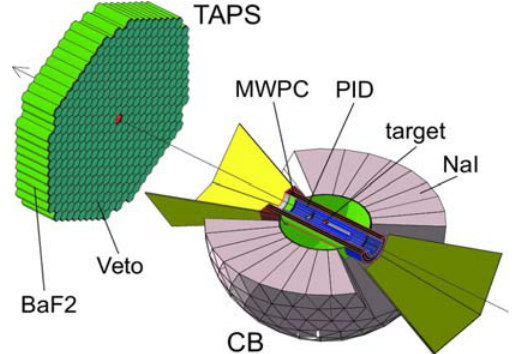
Figure 2: Schematic diagram of the experimental setup [5].